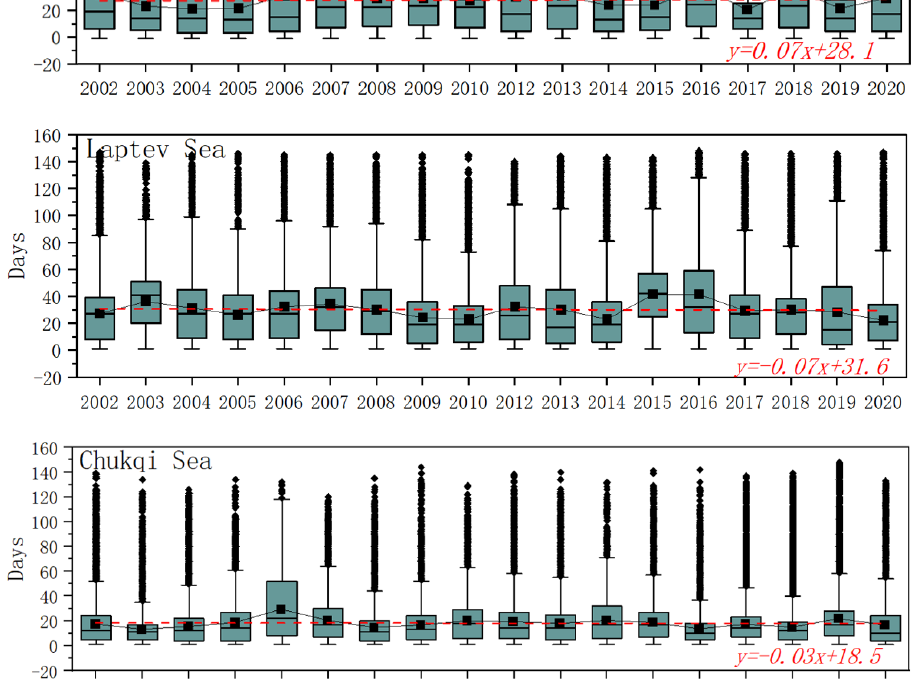
Figure 12. Number of days from breaking up to complete melting of Arctic sea ice, 2002 – 2020.